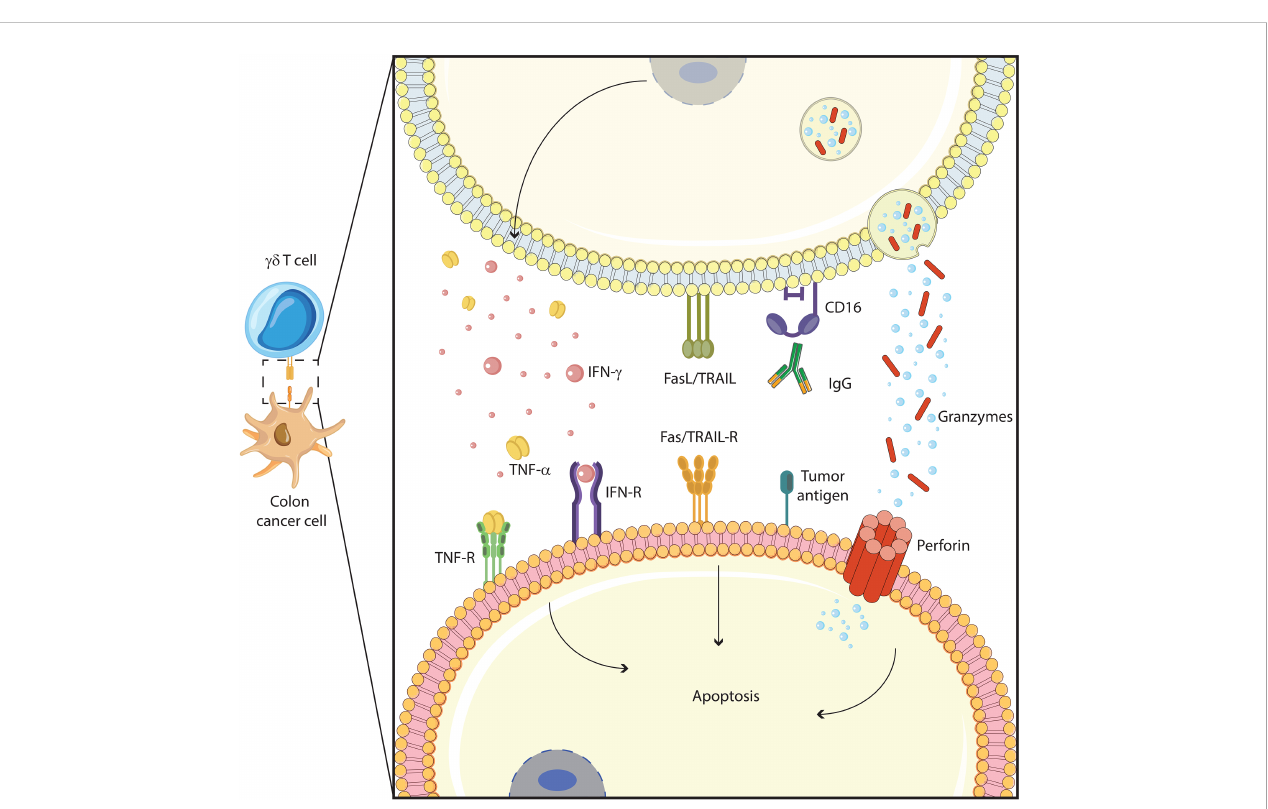
FIGURE 2 gd T cells function against colon cancer cells. gd T cells exert their cytotoxic functions through several mechanisms: induction of apoptotic cell death with Fas/TRAIL pathway, antibody-dependent cellular cytotoxicity (ADCC) with IgG/CD16 interaction, cytolytic granule (granzyme, perforin) polarization and degranulation, and proin fl ammatory cytokines (TNF- a , IFN- g )